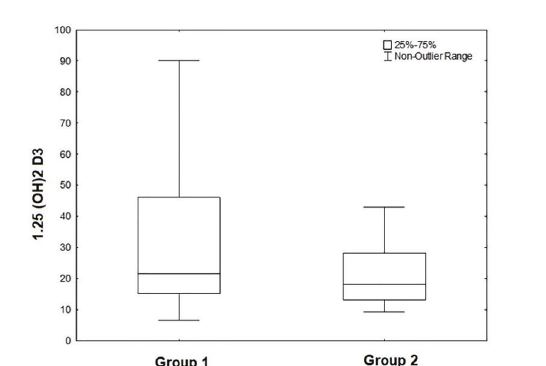
Figure 1 - Comparison of the patient groups by 1.25(OH)2D3 levels